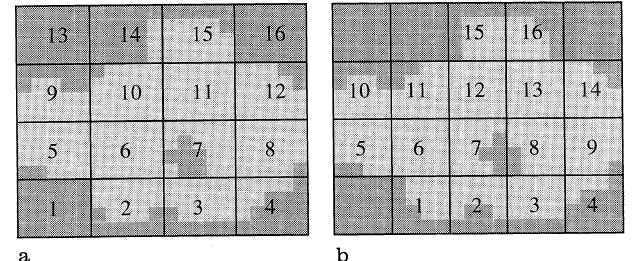
Fig. 9a,b. A regular two-dimensional decomposition of an ocean model, containing land ( dark-shaded ) and ocean ( light-shaded ) points, can result in some processors having no work (as highlighted in a by processors 1, 13 and 16). By sub-dividing the domain into a greater number of smaller sub-domains, those with no work can be ignored completely and a better utilisation of the sixteen available processors can be achieved (as highlighted in b )